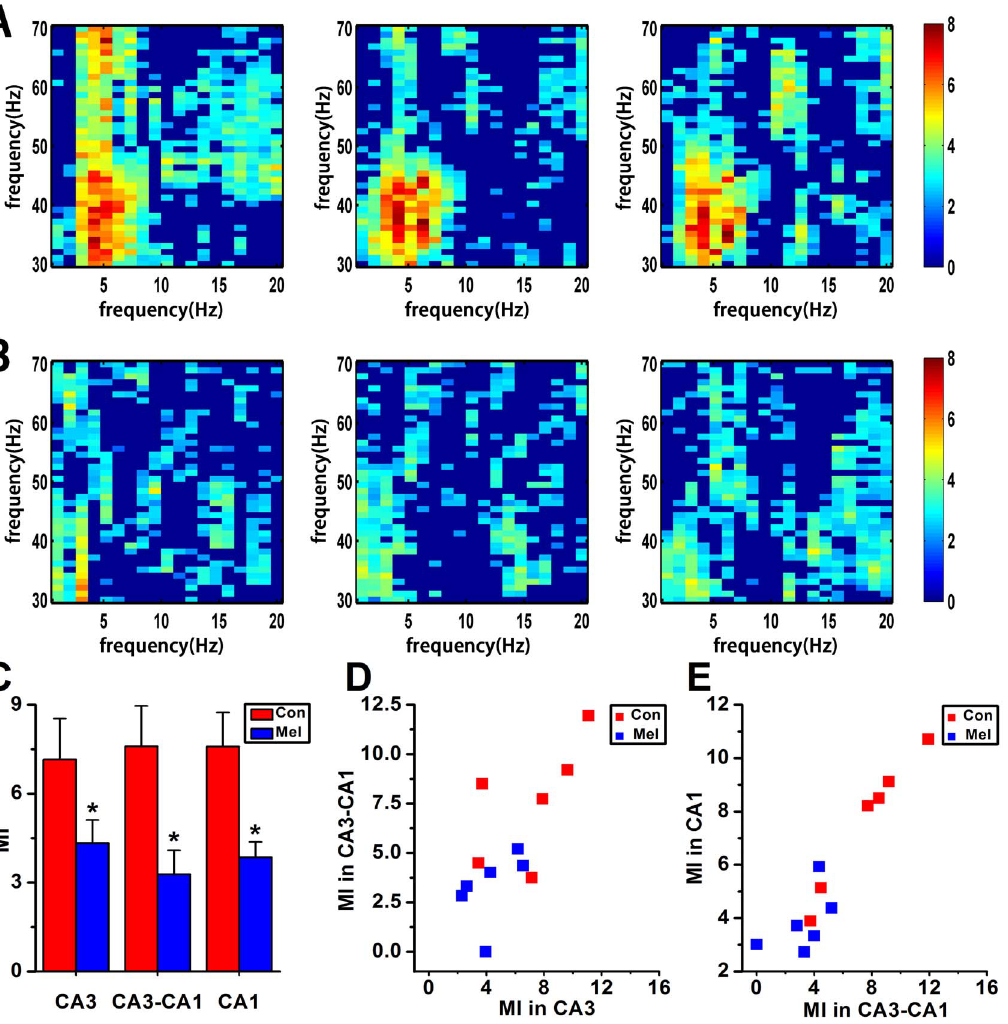
Figure 4. MI analysis in CA3-CA1 network in Con and Mel groups. A & B. The modulation index as a function of analytic amplitude (30 to 70 Hz) and phase (1 to 20 Hz) in CA3, CA3-CA1 and CA1 in both Con and Mel groups. The higher MI value the stronger cross frequency coupling. C. Statistical MI data of phase-amplitude coupling between theta and gamma rhythms in hippocampal CA3-CA1 network. *P , 0.05 for comparison between Con group and Mel group. D. Scatter plot of CA3 MI data vs. CA3-CA1 MI data for all normal and melamine-treated rats. E. Scatter plot of CA3-CA1 MI data vs. CA1 MI data for all normal and melamine-treated rats.